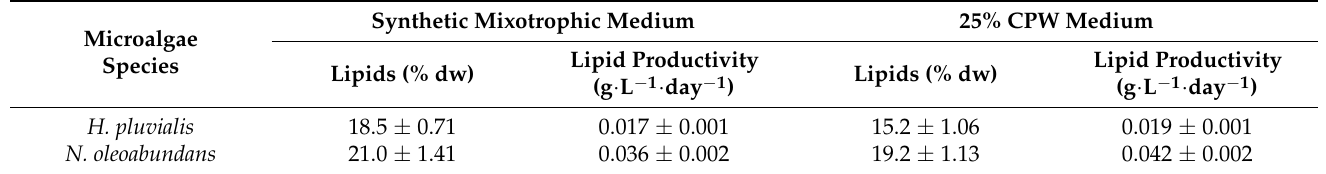
Table 6. Total lipid content (% dw) and lipid productivity (g · L − 1 · day − 1 ) in H. pluvialis and N. oleoabundans , cultured in the synthetic mixotrophic medium and 25% CPW medium. Values are the mean ± standard error of three replicates.